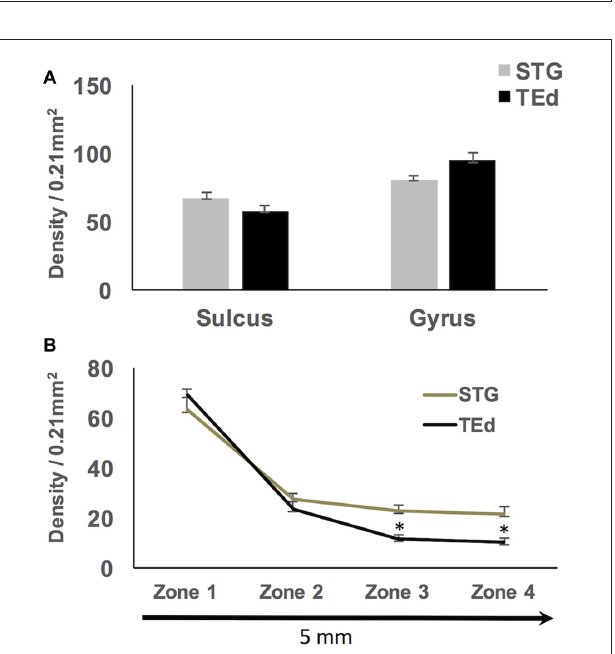
FIGURE 7 | (A) No significant differences in density of sulcal and gyral WMNs were found between superior temporal gyrus (STG) and inferior temporal gyrus (TEd). (B) Significantly progressive fall-off in WMN density with distance from the gyral crown; the fall off in density of WMNs was significantly different between STG and TEd at the most distal zones. ∗ p < 0.05.